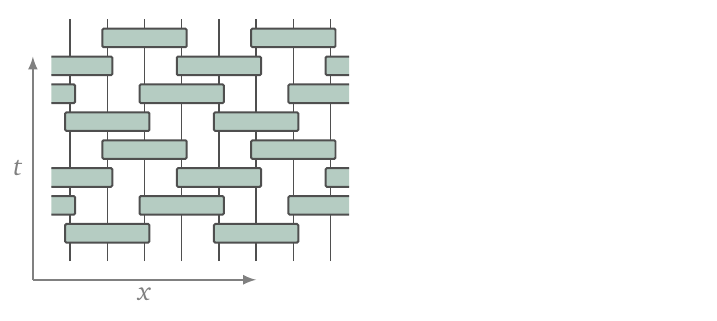
Figure 1: Graphical representation of the time evolution operator up to time t =